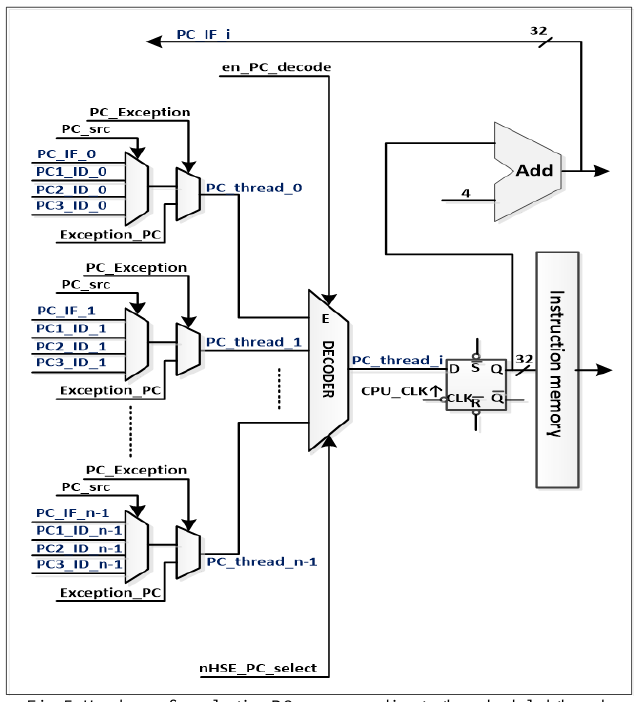
Fig. 5. Hardware for selecting PC corresponding to the scheduled